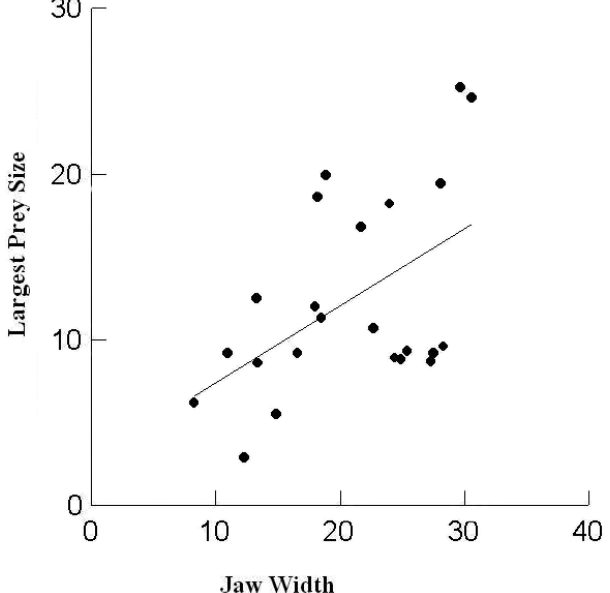
Fig. 2 – Relationship between jaw width (mm) and length (mm) of the biggest prey found in the stomach of Proceratophrys boiei in two Atlantic rainforest remnants in the State of Rio de Janeiro (R 2 = 0 . 26; F 1 , 21 = 7 . 3; P = 0 . 013).